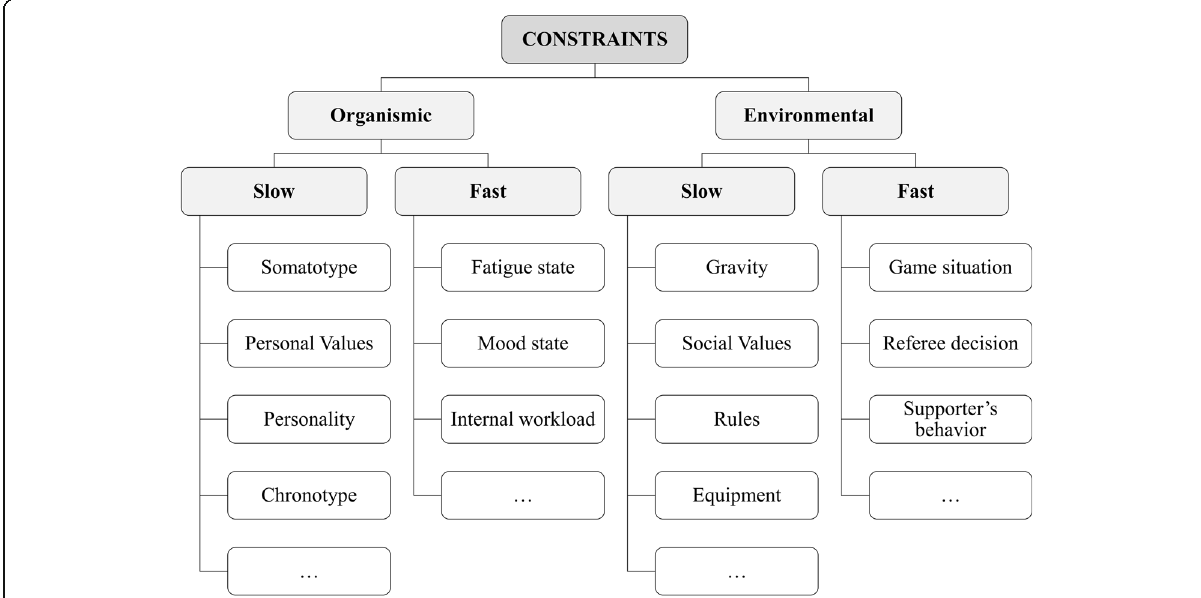
Fig. 3 Classification of organismic and environmental constraints according its relatively faster or slower rate of change. Some examples are